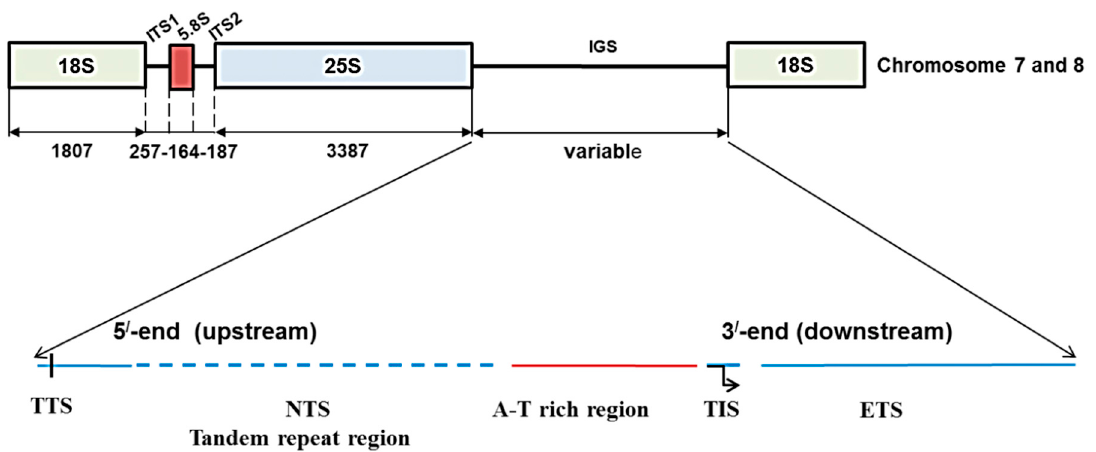
Figure 1. Ribosomal DNA array and organization of intergenic spacer (IGS) in Brassica oleracea based on Tremousaygue et al. [31] and the present study. Diagram shows position of 45S IGS region in between 25S and 18S rDNA subunits. TTS, transcription termination site; NTS, non-transcribed spacer; TIS, transcription initiation site and ETS, external transcribed spacer.